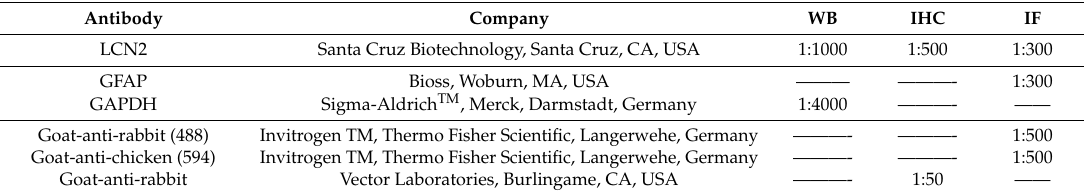
Table 2. List of